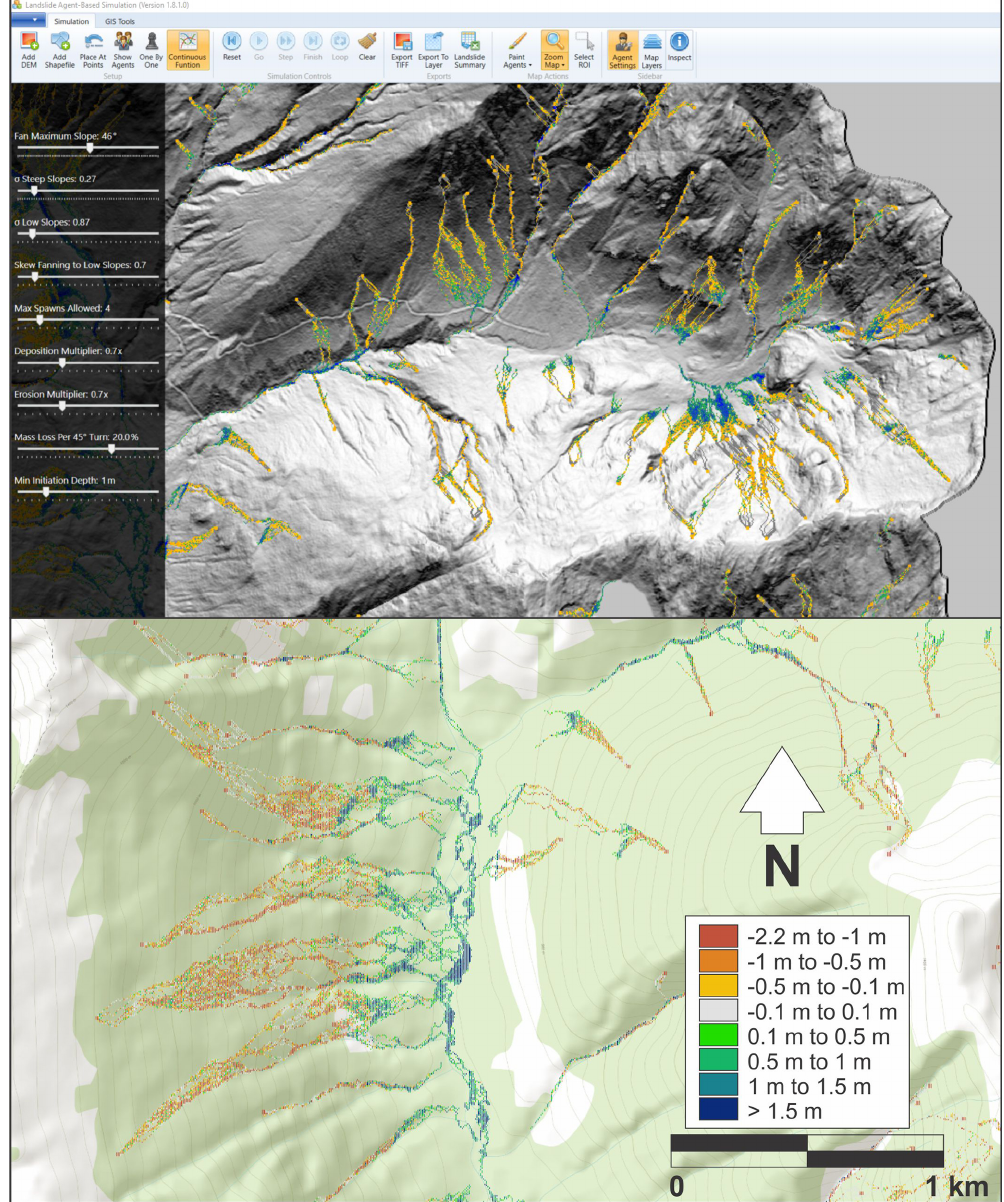
Figure 13. Landslides generated from susceptible slopes in DebrisFlow Predictor. Bottom figure shows depths along the landslide